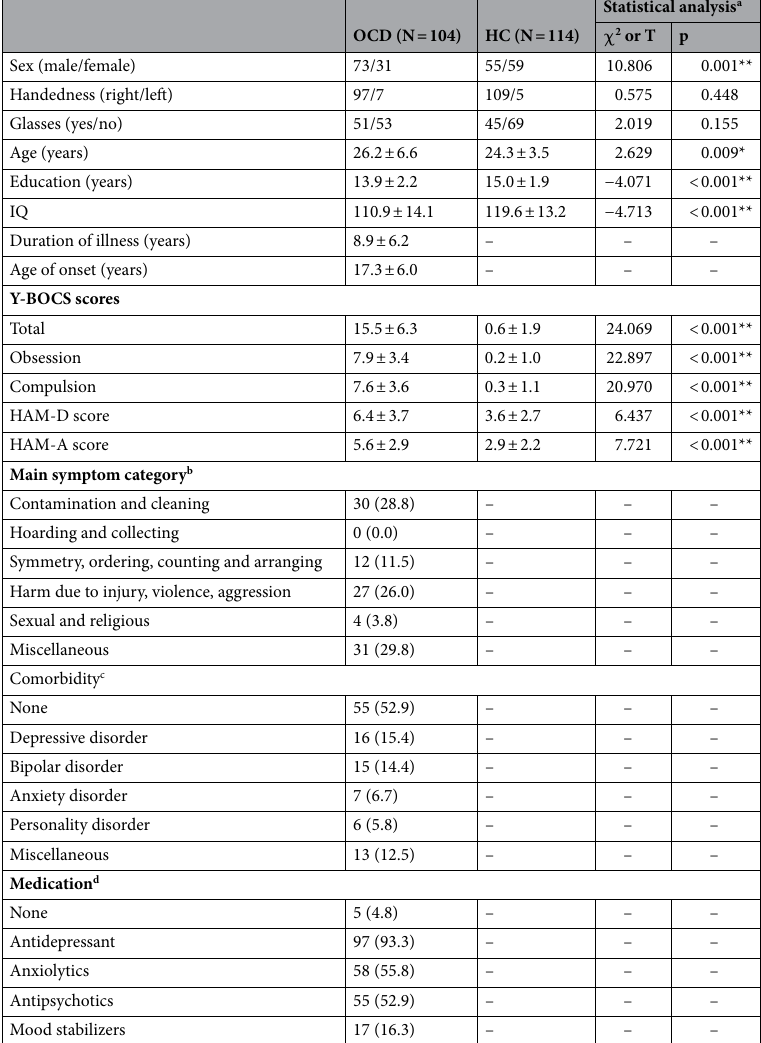
Table 1. Demographic and clinical characteristics of the patients with obsessive–compulsive disorder (OCD) and healthy controls (HCs). IQ intelligence quotient, Y-BOCS Yale-Brown Obsessive Compulsive Scale, HAM- D Hamilton Rating Scale for Depression, HAM-A Hamilton Rating Scale for Anxiety. *The mean difference is significant at the 0.05 level. **The mean difference is significant at the 0.005 level. a Independent t test or Welch’s t test if the variances were not equal and χ 2 analysis or Fisher’s exact test for categorical data. b Number (percentage) of patients who showed each main symptom on the dimensional Y-BOCS. c Number (percentage) of patients who were diagnosed with each comorbid psychiatric disorder. For depressive disorder, 16 patients were diagnosed with depressive disorder, not otherwise specified (NOS). For bipolar disorder, 2 patients were diagnosed with bipolar I disorder, 12 with bipolar II disorder, and 1 with bipolar disorder, NOS. For anxiety disorder, 6 patients were diagnosed with panic disorder and 1 with anxiety disorder, NOS. For personality disorder, 2 patients were diagnosed with schizotypal personality disorder, 3 with obsessive–compulsive personality disorder, and 1 with avoidant personality disorder. In the miscellaneous group, 7 patients were diagnosed with trichotillomania, 3 with tic disorder, 2 with Tourette’s disorder, and 1 with adjustment disorder. d Number (percentage) of patients who were prescribed each medication. Data are given as the mean ± standard